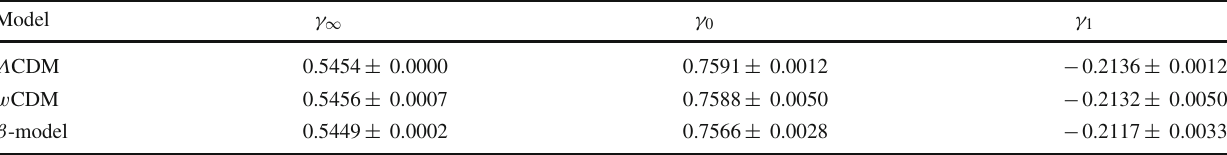
Table 4 A summary of the obtained values of growth index for the studied models in the k ∼ 0 . 1 hMpc − 1 scale. The Λ CDM model is adopted